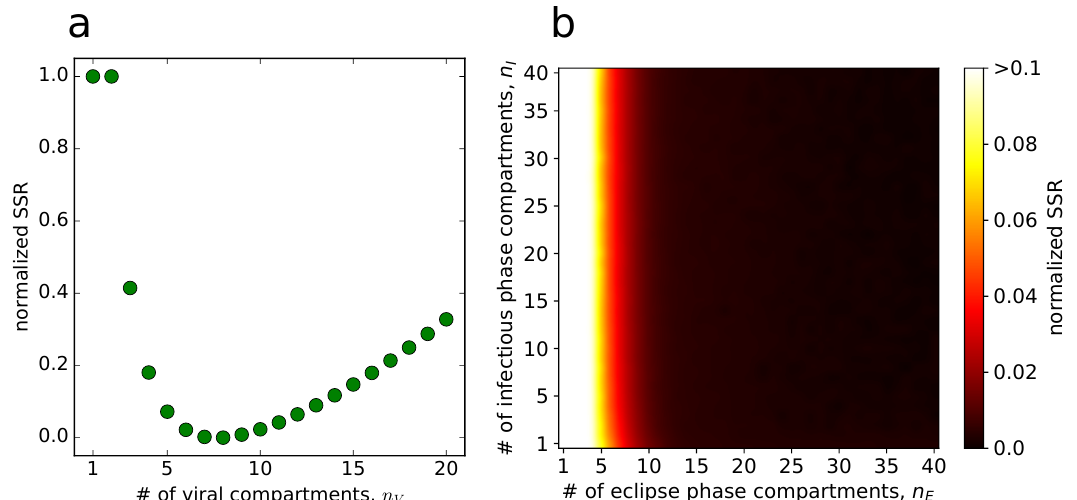
Figure 2. Selecting the number of compartments n pfu , n E and n I . For each n pfu and a pair ( n E , n I ), we calculated the relative value of the objective function obtained from fitting as a fraction (SSR SSR min )/(SSR max SSR min ), where SSR (sum of squared residuals) is the best-fit value of the objective − function for a given n pfu or a pair ( n E , n I ) and SSR max and SSR min are the lowest and highest values out of all objective function values. The normalized values range between 0 (best fits) and 1 (worst fits). ( a ) To determine n pfu , and thus the number of compartments in the decay model (2), Formula (S4) in Supplementary Materials File S1 was used. Here, the maximum and minimum values of the objective function (S4) over all n pfu were SSR max = 124.29 and SSR min = 28.33. ( b ) To determine n E and n I , and thus the number of eclipse and infectious compartments in the model (3), Equation (S7) in Supplementary Materials File S1 was used. Here, the maximum and minimum values of the objective